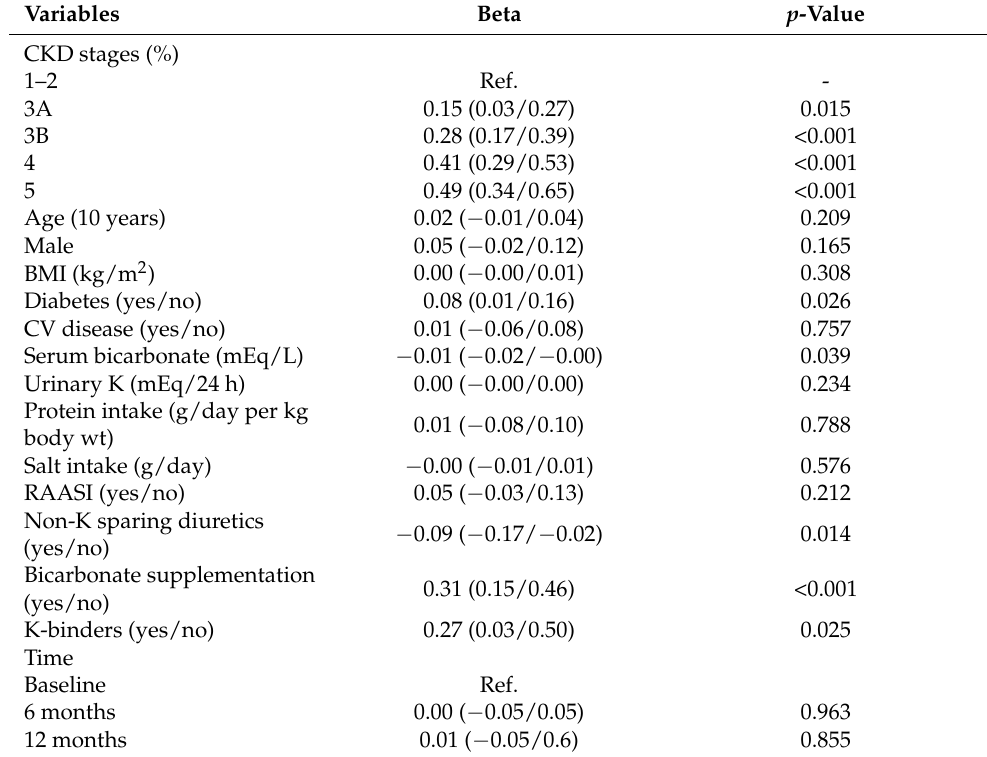
Table 3. Mixed effect regression estimating basal determinants of time-dependent serum